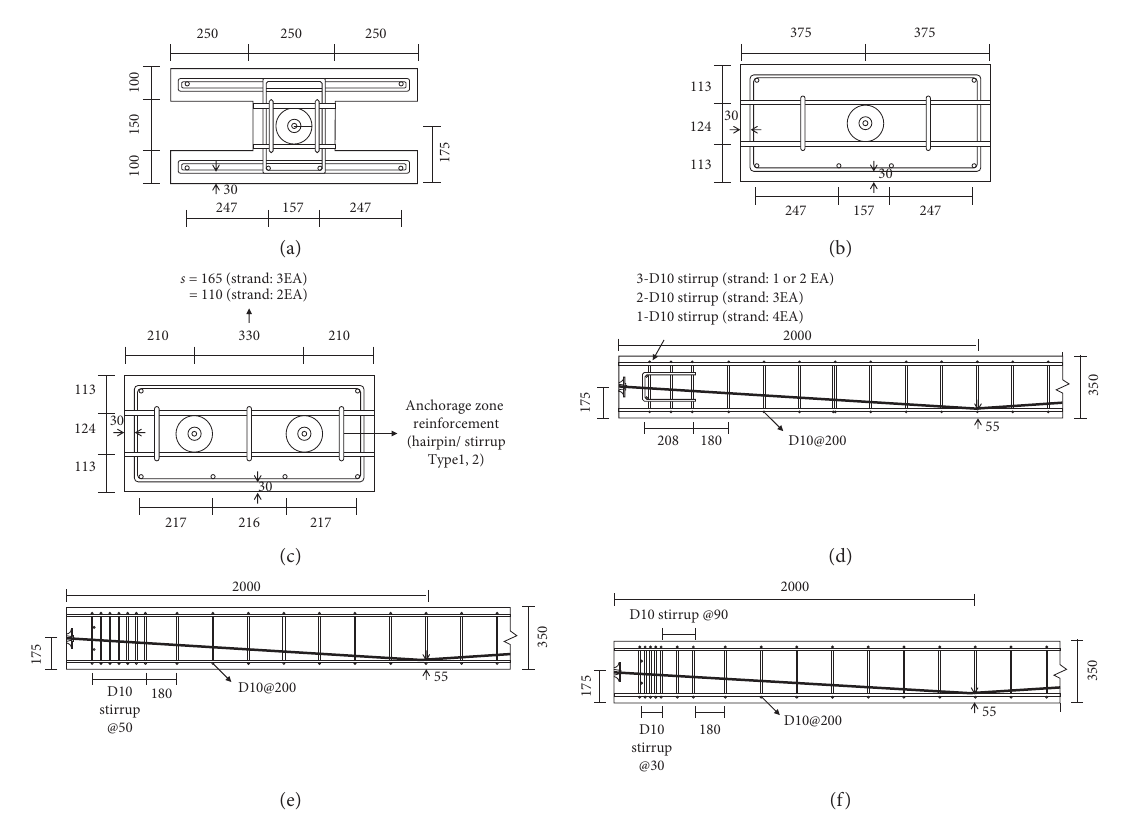
Figure 3: Details of specimens (mm). (a) Front view of HIP-1 and GIP-1; (b) front view of HRP-1 and GRP-1; (c) front view of the other specimens; (d) side view of reinforced hairpin specimens; (e) side view of reinforced stirrup specimens (Type 1); and (f) side view of reinforced stirrup specimens (Type